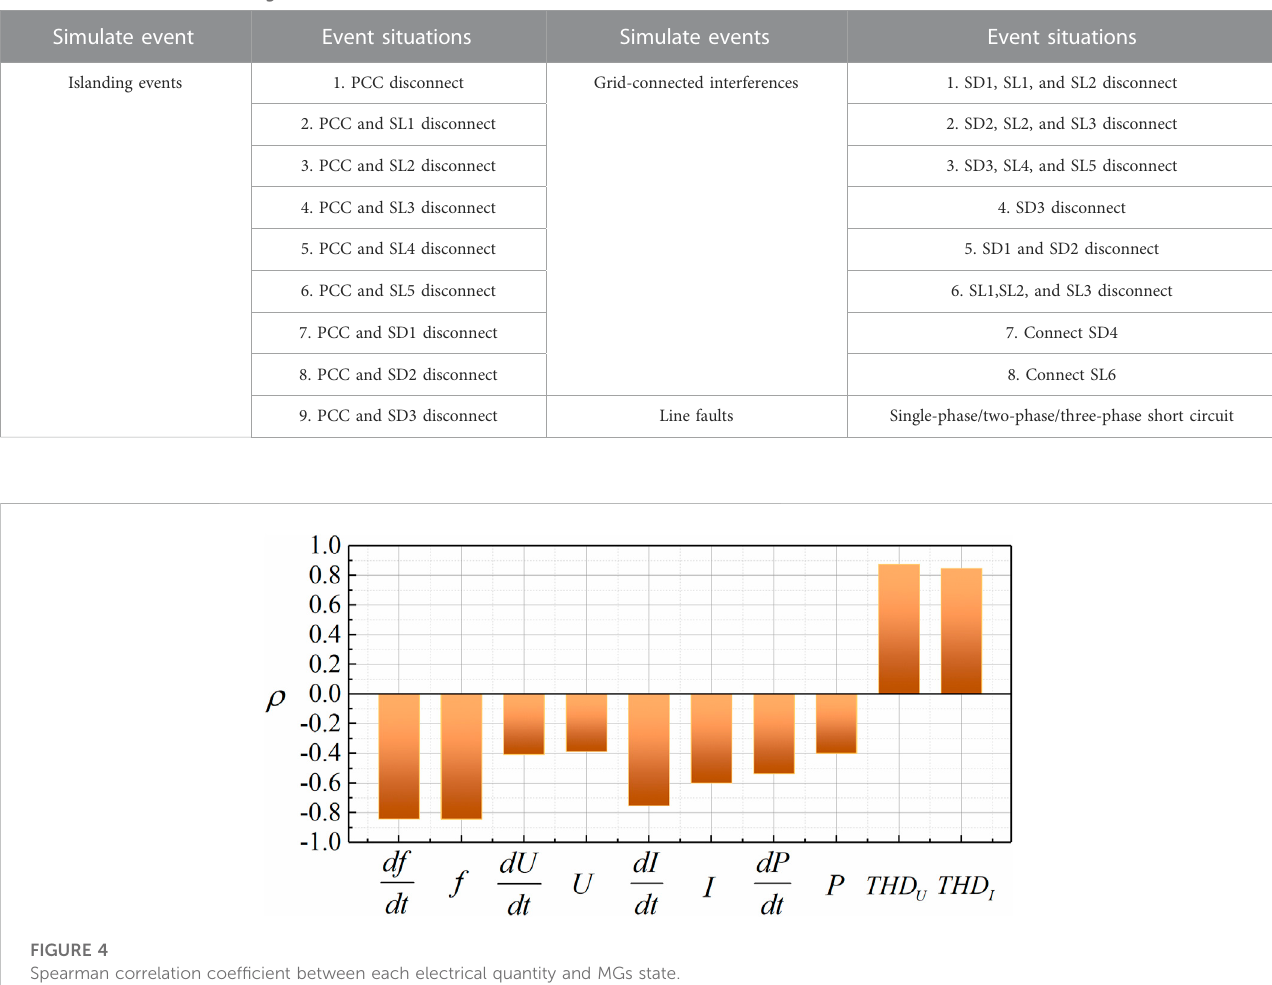
TABLE 4 MG different state settings.